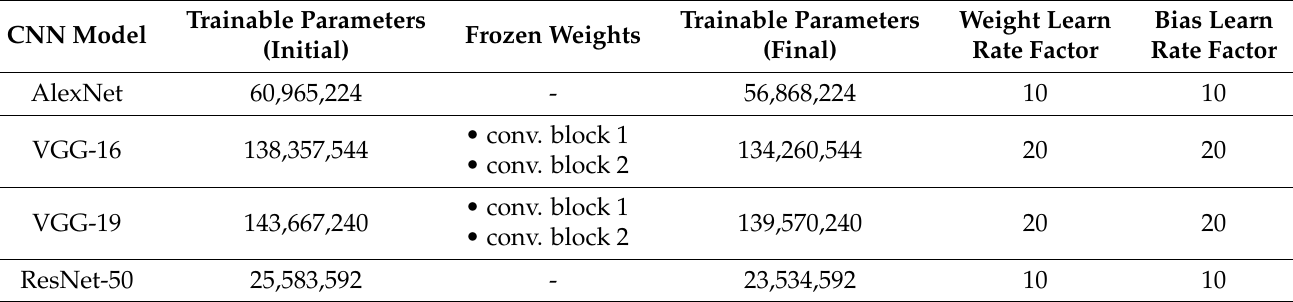
Table 2. Applied parameters for transfer learning to pretrained CNN